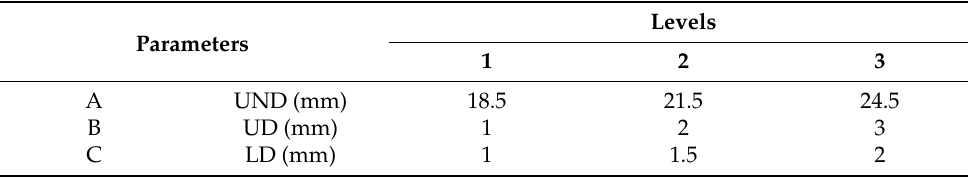
Table 2. List of the geometric design parameters and their